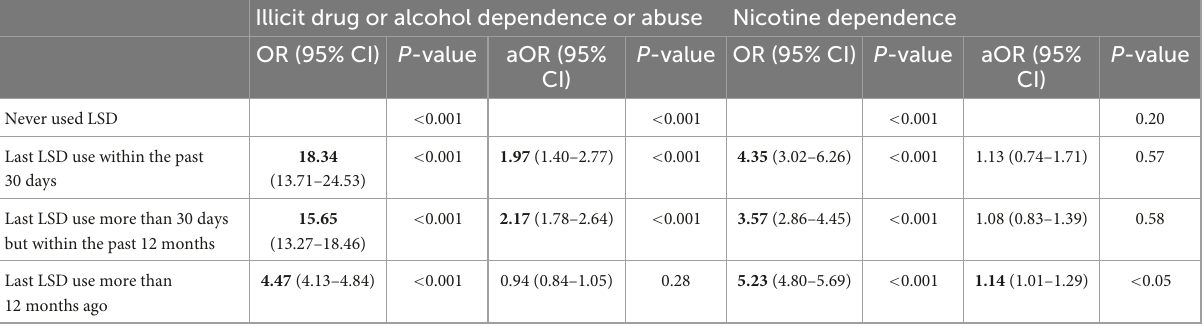
TABLE 4 Odds ratios (OR) and adjusted odds ratios (aOR) of past year illicit drug or alcohol dependence or abuse and nicotine dependence among individuals based on recency of last LSD use. Illicit drug or alcohol dependence or abuse Nicotine